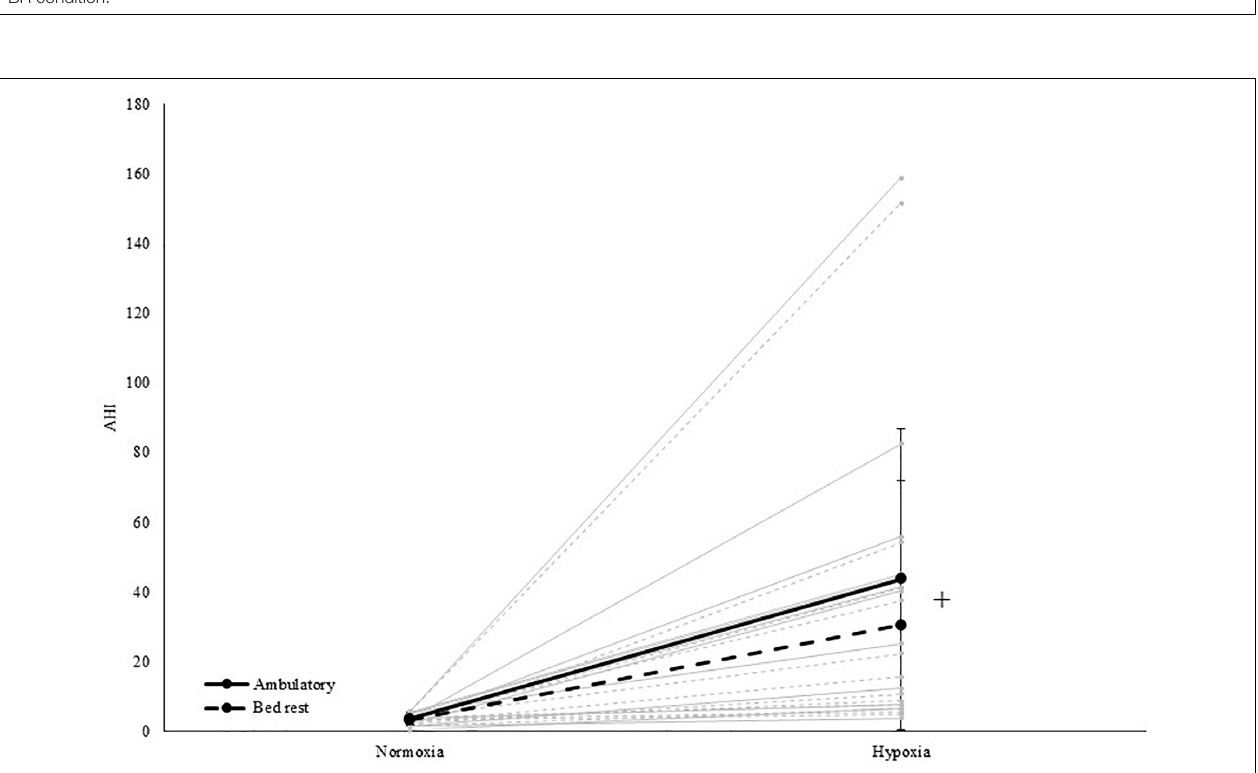
FIGURE 3 | Apnea-hypopnea index in both normoxia and hypoxia and when being active (i.e., ambulatory) and inactive (i.e., BR). +Represents a significant main effect of PO 2 . Solid grey lines represent the individual response to hypoxia in an ambulatory condition, dashed grey lines represent the individual response to hypoxia in a BR condition.